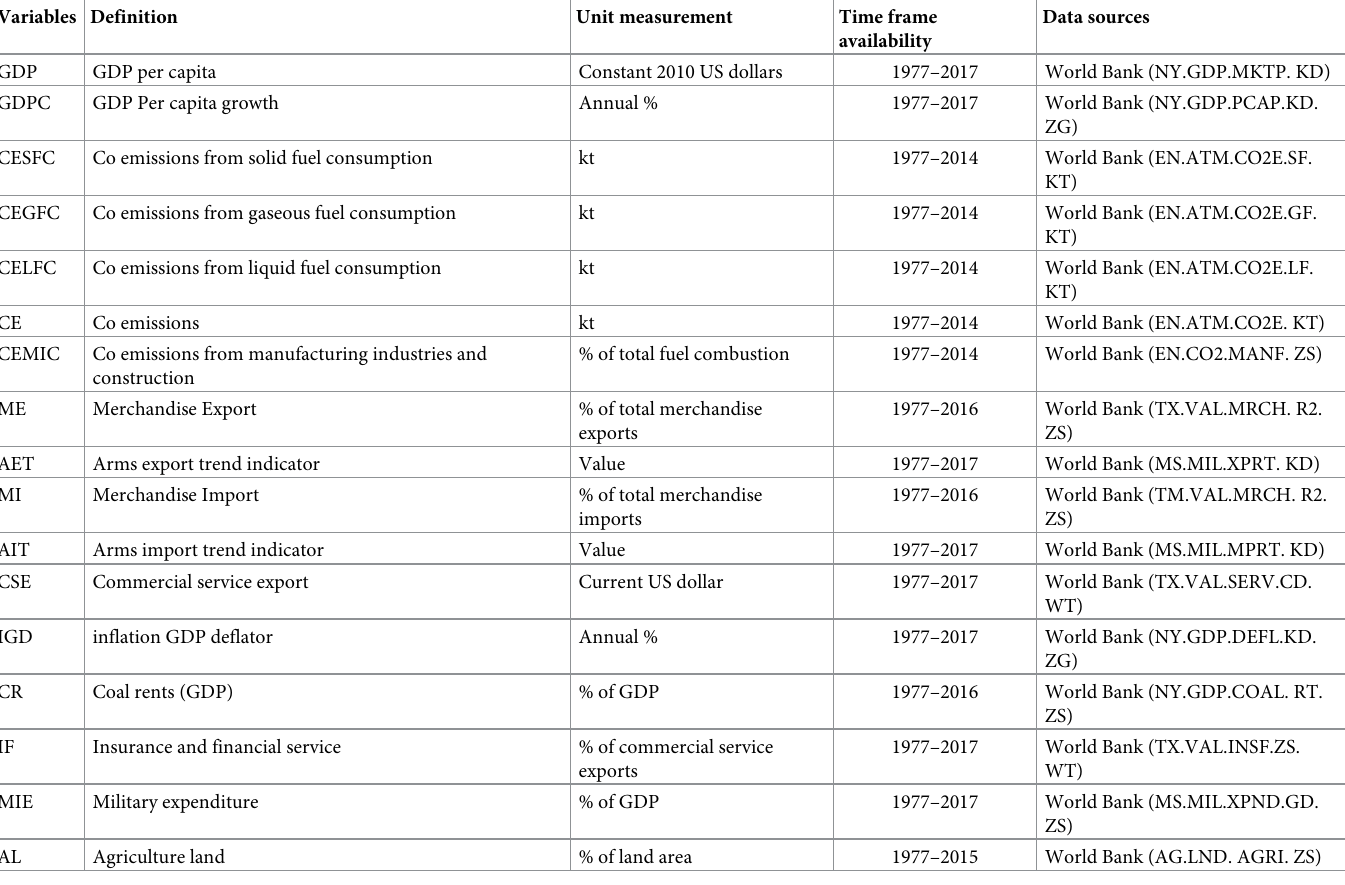
Table 2. Variables description for the